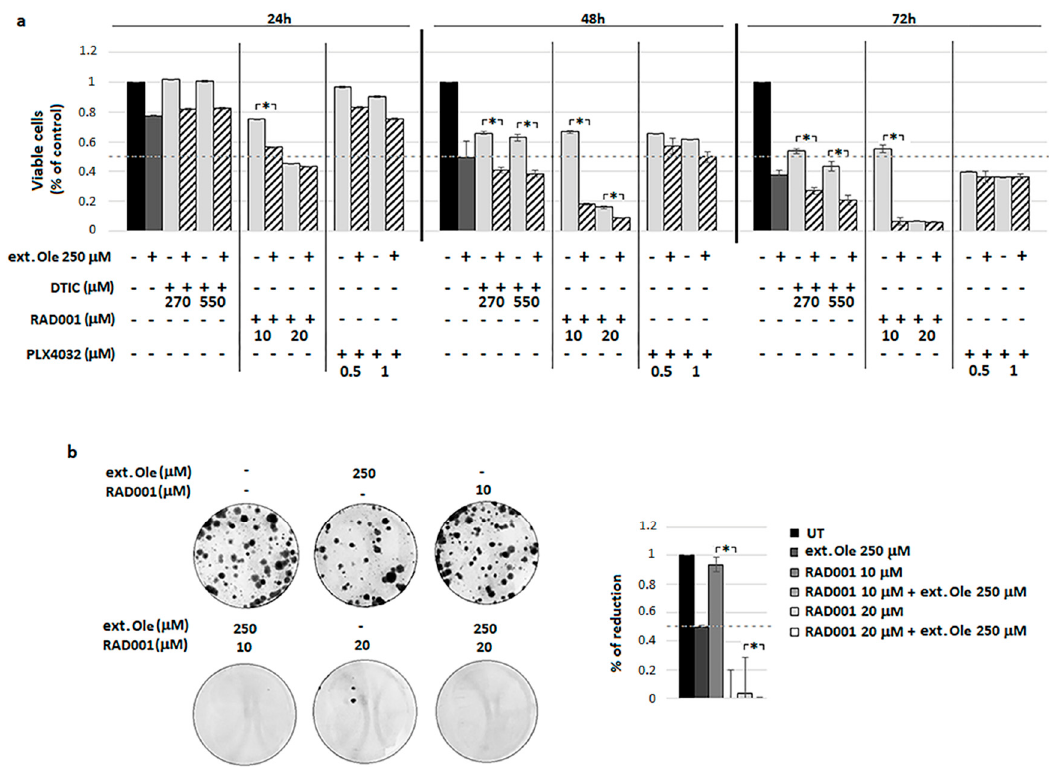
Figure 5. Effects of Ole-enriched leaf extract alone or in combination with DTIC, RAD001, or PLX4032 on A375 melanoma cells. ( a ) Dose–time response evaluated via MTT assay. * p ≤ 0.05 refers to OleRAD001/DTIC treatment vs. RAD001/DTIC alone. ( b ) ( Left ) Colonies forming units (CFU) assay of alive cells selected using a trypan blue exclusion test after Ole-enriched leaf extract treatment with and/or RAD001 for 24 h. ( Right ) Quantification data of colony numbers with respect to UT. * p ≤ 0.05 refers to Ole-DTIC or Ole-RAD001 treatment compared to DTIC or RAD001 alone. UT = untreated.